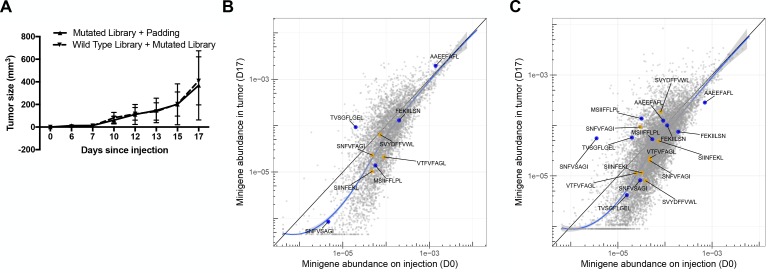
Five C57BL6/N mice were injected with 5 × 106 RMA/S cells bearing the mutated peptide library plus 1 × 106 untransduced RMA/S cells (‘padded’ mutant peptide library) to provide a buffer against bystander killing in the event that most of the cells in the tumor were immunogenic.An additional five C57BL6/N mice were injected with a mixture of 107 wild type library and mutated library cells. (A) Growth curves for tumors bearing the ‘padded’ mutated peptide library and mutated peptide library cells. A scatter plot showing the average frequency of each minigene in the (B) ‘padded’ mutated peptide library or (C) mixed wild type and mutated peptide library before and after growth in wild type mice. The abundance of each minigene in culture (x-axis; n = 3) versus the abundance of each minigene after 17 days of growth in a wild type mouse (y-axis; n = 5). Orange circles indicate positive control (immunogenic) minigenes; blue circles indicate negative control (non-immunogenic) minigenes. The straight black lines indicate x = y. LOESS (local best fit) lines are plotted in blue.